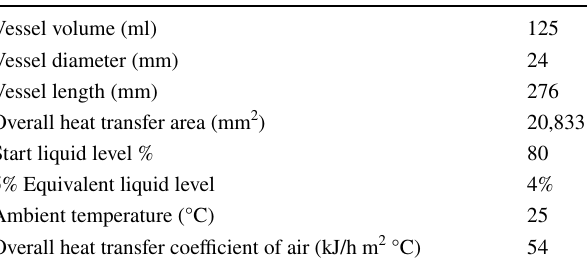
Table 4 Dynamic data for the weathering tube